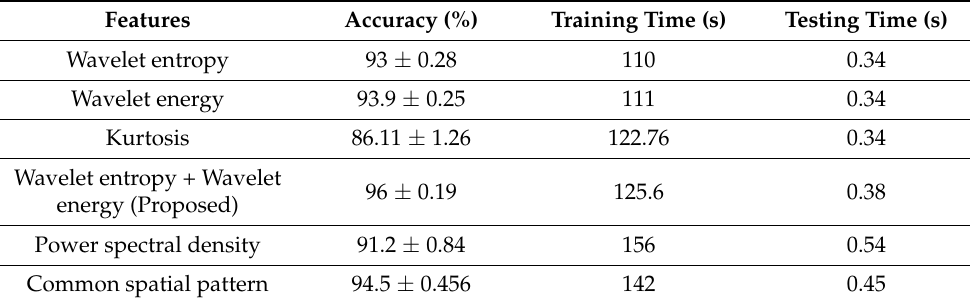
Table 3. Performance of the proposed method with different features.